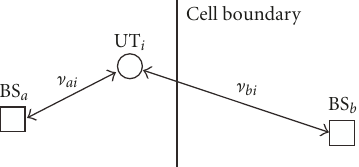
Figure 5: Cellular network topology with two BSs and one UT.